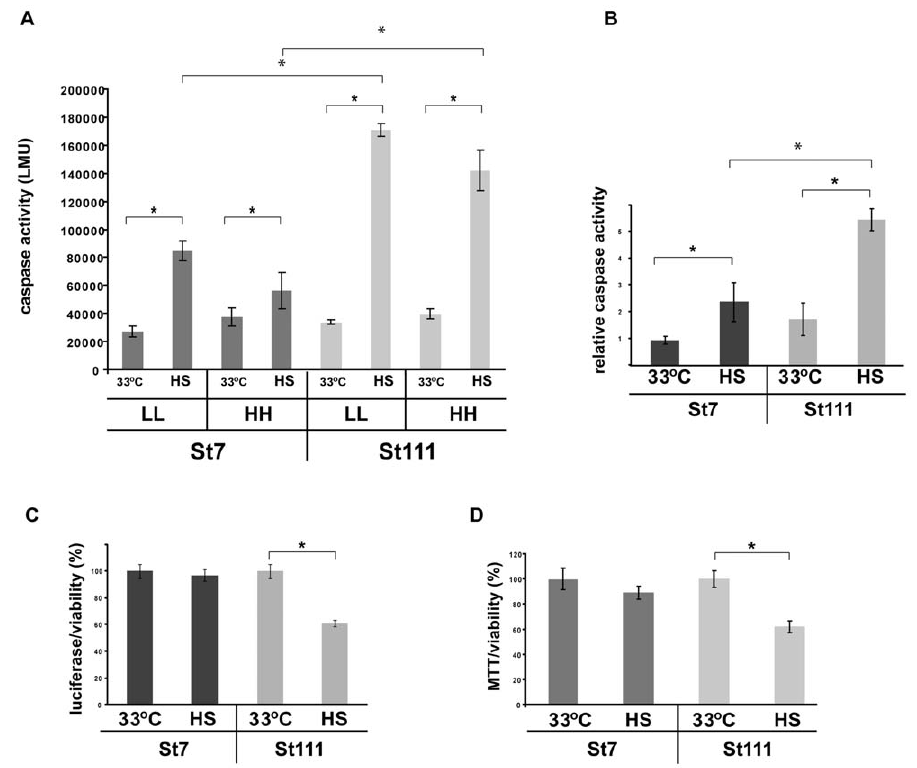
Figure 1. Decreased resistance to a heat shock in cells expressing polyQ-expanded Htt. A ) Caspase assay of cells that were grown at 33 u C and of heat shocked cells (six hours at 42 u C). In either medium containing high concentrations of glucose and serum (HH) or lower concentration of glucose and serum (LL). The error bars represent SDs. Results from four independent experiments were analyzed. * p , 0.1 (two tailed t-test). B ) Relative caspase activities (from Figure 1 A). The values for non heat shocked cells were set as 1 and the other signals were calculated accordingly. C ) Viability assay (luciferase activity, Promega) of STHdh(Q7) and STHdh(Q111) cells that were grown at 33 u C and of heat shocked cells (six hours at 42 u C). The signals from STHdh(Q7) cells grown at 33 u C was set as 100% and the other signals were calculated accordingly. The error bars represent SDs. Results from four independent experiments were analyzed. * p , 0.05 (two tailed t-test). D MTT assay of STHdh(Q7) and STHdh(Q111) cells that were grown at 33 u C and of heat shocked cells (six hours at 42 u C). The signals from STHdh(Q7) cells grown at 33 u C was set as 100% and the other signals were calculated accordingly. The error bars represent SDs. Results from four independent experiments were analyzed. * p , 0.05 (two tailed t- test). Experiments shown under B), C), and D) were carried out using LL